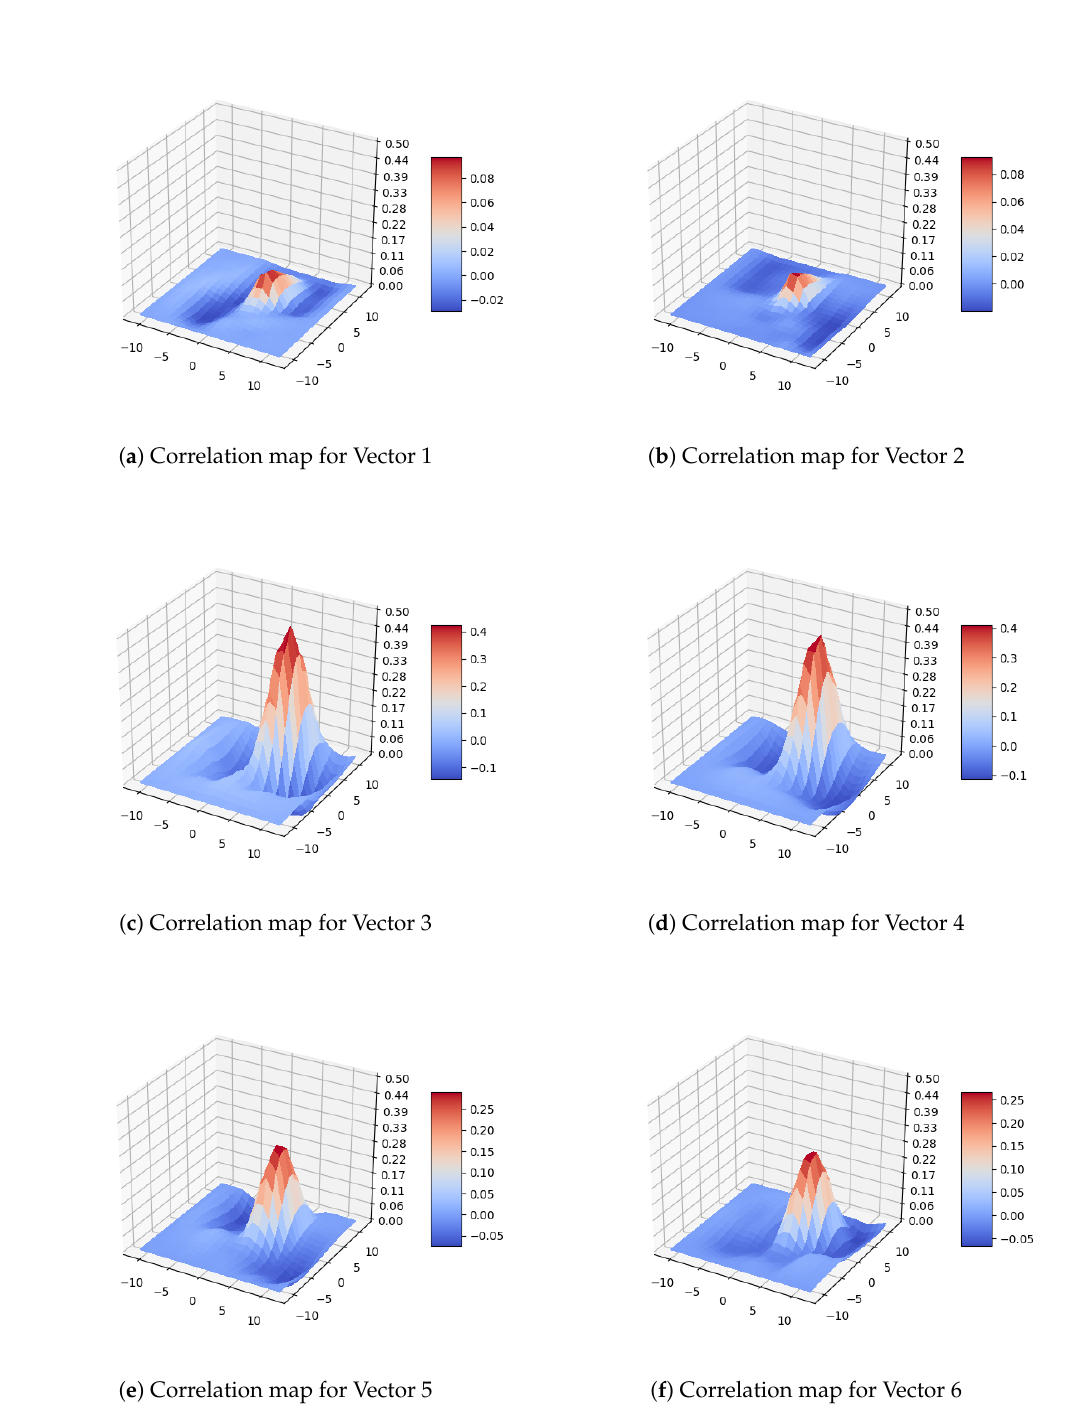
Figure 7. 3D plots of correlation matrices for the motion vectors in Figure 6c. Each row in the figure corresponds to each row in the vector plot of Figure